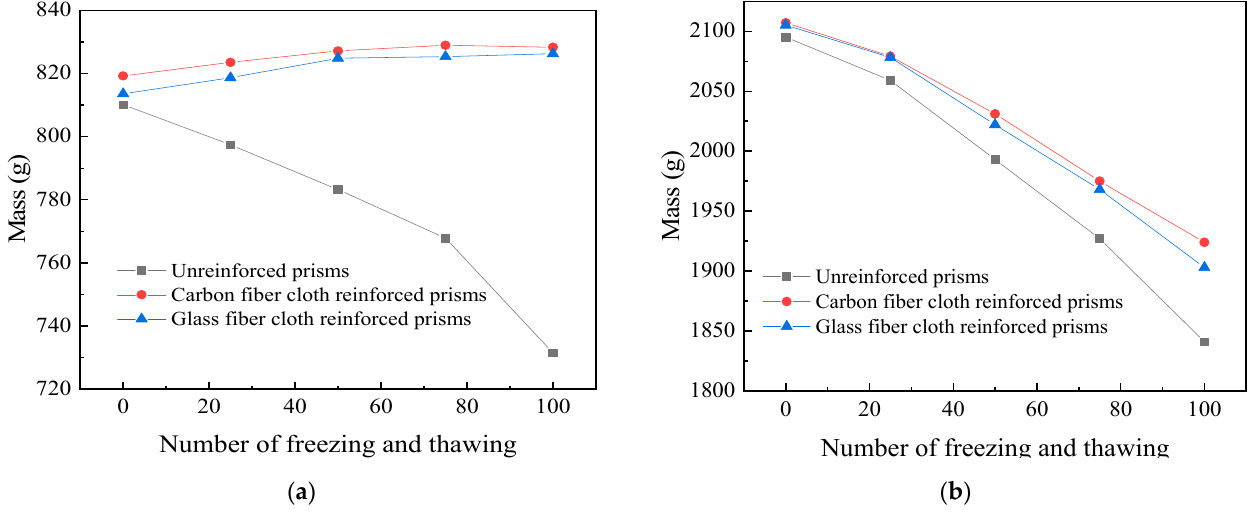
Figure 6. Mass changes under freeze–thaw cycles: ( a ) FRP-reinforced concrete cylinder; ( b ) FRP- reinforced concrete prism.